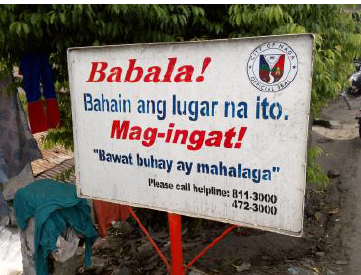
Figure 18. Left - An undated photo of an estuary from Miller's "Glimpses of Old Cebu" possibly showing Parian Estuary.